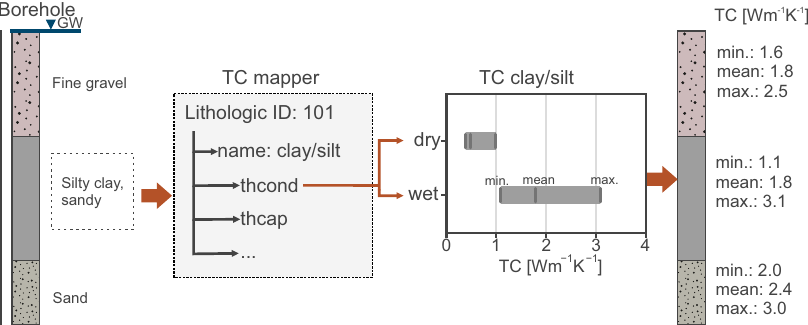
Figure 2. Translation of stratigraphic sequences to thermal conductivities. A petrographic term from a borehole interval is assigned to the closest lithologic ID in the TP mapper. Next, either wet or dry properties are assigned to the sequence, depending on the groundwater